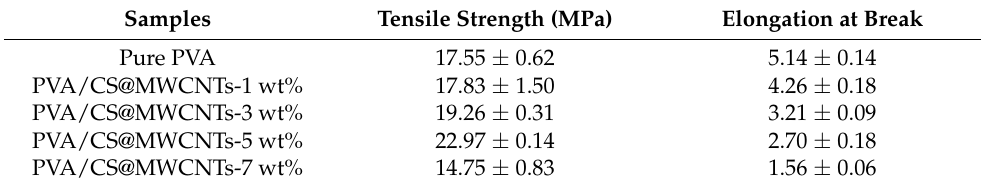
Table 2. Representative mechanical properties of the samples. Samples Tensile Strength (MPa) Elongation at